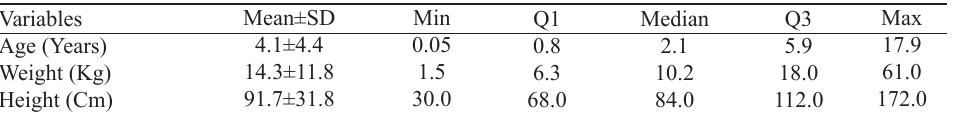
Fig. 1 - Distribution of procedures in the categories of the three methods of stratification of complexity: RACHS-1, STS-EACTS (STAT) and Aristotle Basic (ABC). RACHS-1 (Categories 1,2,3,4,5 and 6); STS-EACTS (STAT) (1,2,3,4 and 5 categories); Aristotle basic (ABC) (categories 1,2,3 and 4). We did not have procedures in categories 5 and 6 according to RACHS-1, as well as the category 5 Table 2. Characteristics of patients.